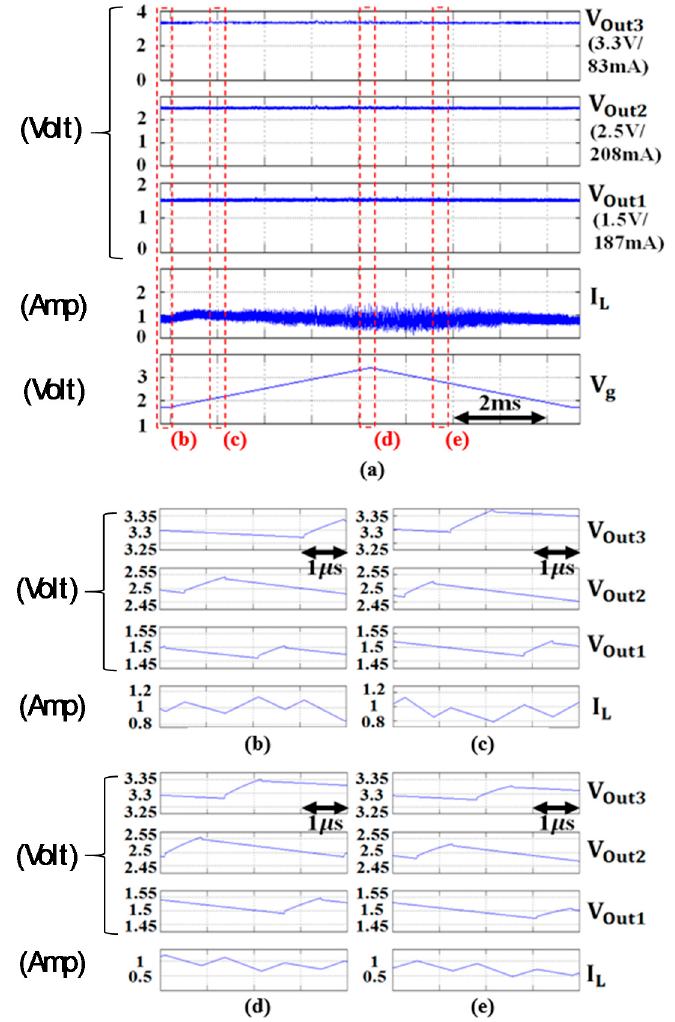
Figure 10. ( a ) Simulated transient waveforms of out voltage of each node and inductor current while V g increases from 1.4 to 3.4 V and decreases from 3.4 to 1.4 V. In order to display details of transient signals, Figure from ( b ) to ( e ) show enlarged parts marked by ( b ), ( c ), ( d ), and ( e ) in Figure 10 ( a ).